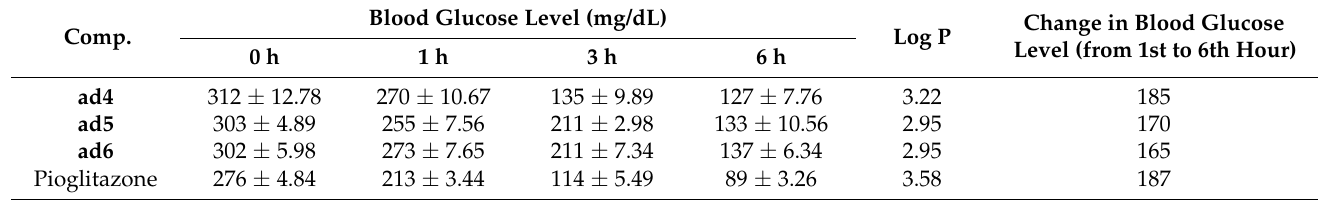
Table 31. Antidiabetic potential of the compounds ( ad4 – ad6 ) in alloxan-induced diabetic rats. Comp.